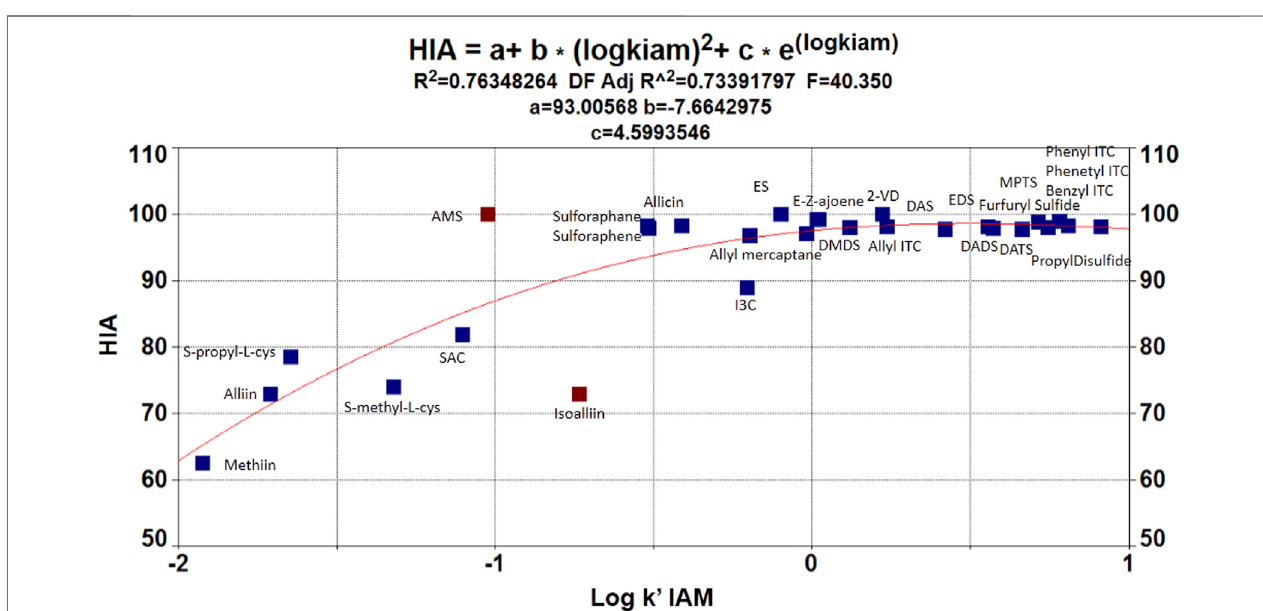
FIGURE 3 | Nonlinear QSAR model showing the relationship between log k ’ (IAM) and (HIA %).